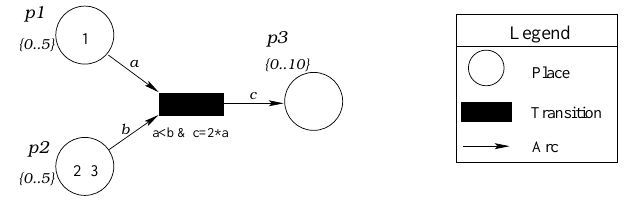
Figure 1: An example of a simple high-level Petri